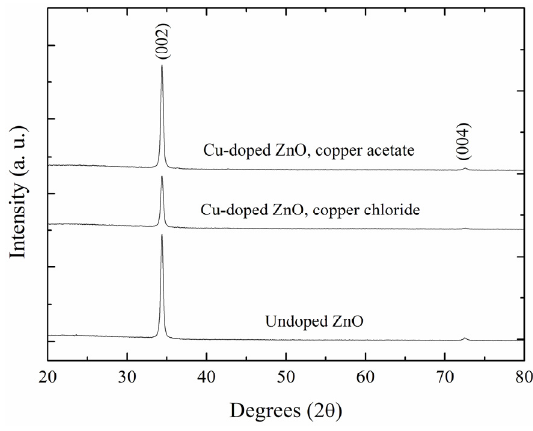
Figure 1. XRD patterns of undoped ZnO and Cu ‐ doped ZnO films.